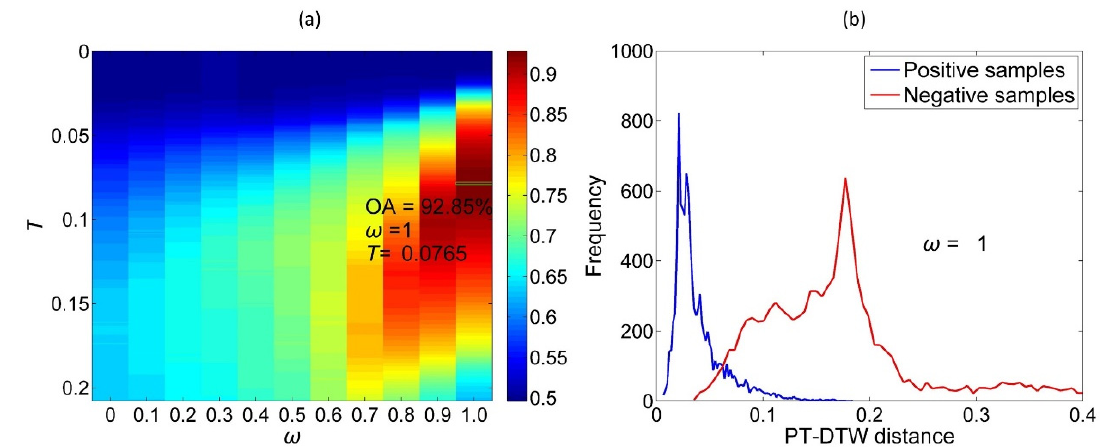
Figure 9. ( a ) Optimization of parameters 𝜔 and T , where the colors denote the overall accuracies of simulated dataset classification. ( b ) Class separability between positive and negative samples when 𝜔 = 1.